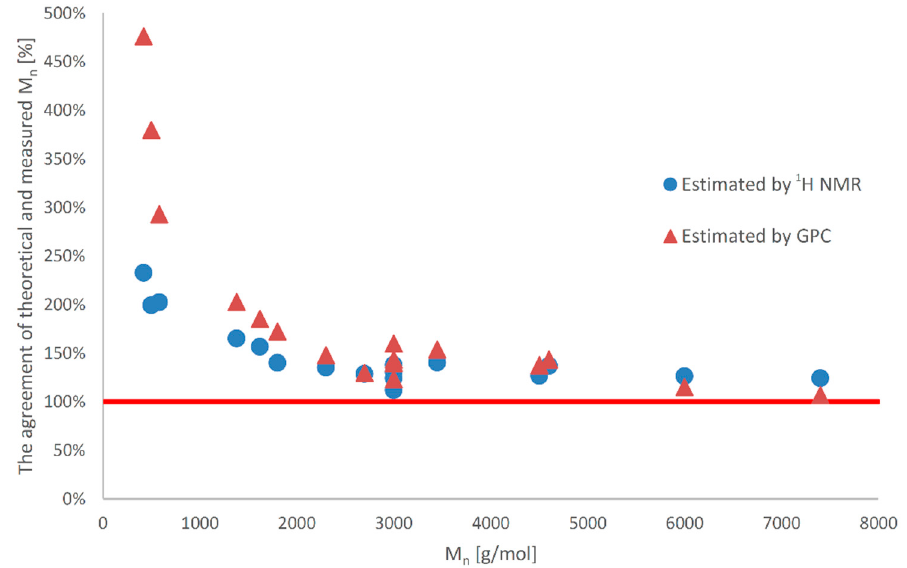
Figure 3. The relationship between the percent agreement of the estimated M n and the theoretical M n .